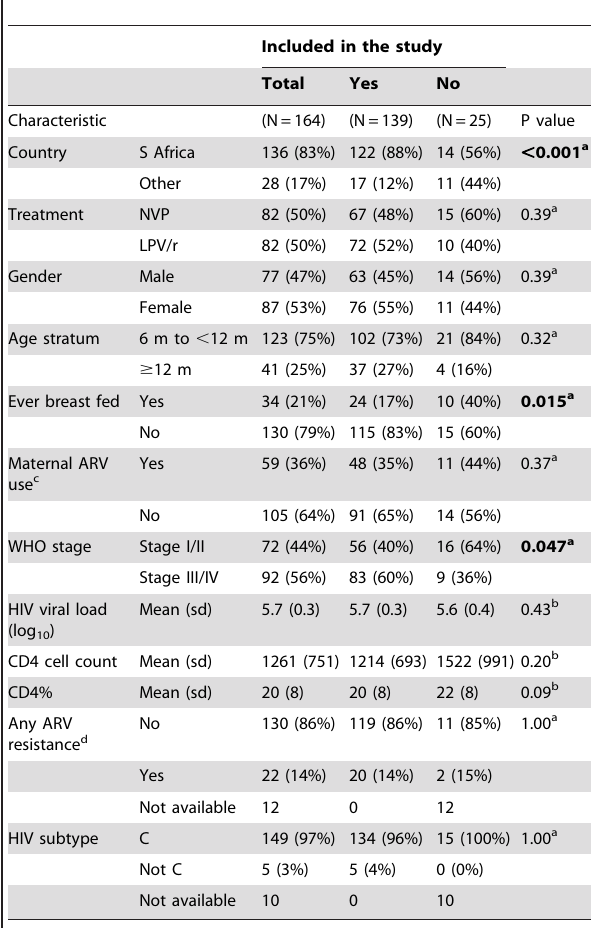
Table 1. Cohort I baseline characteristics overall and by inclusion in the analysis of HIV